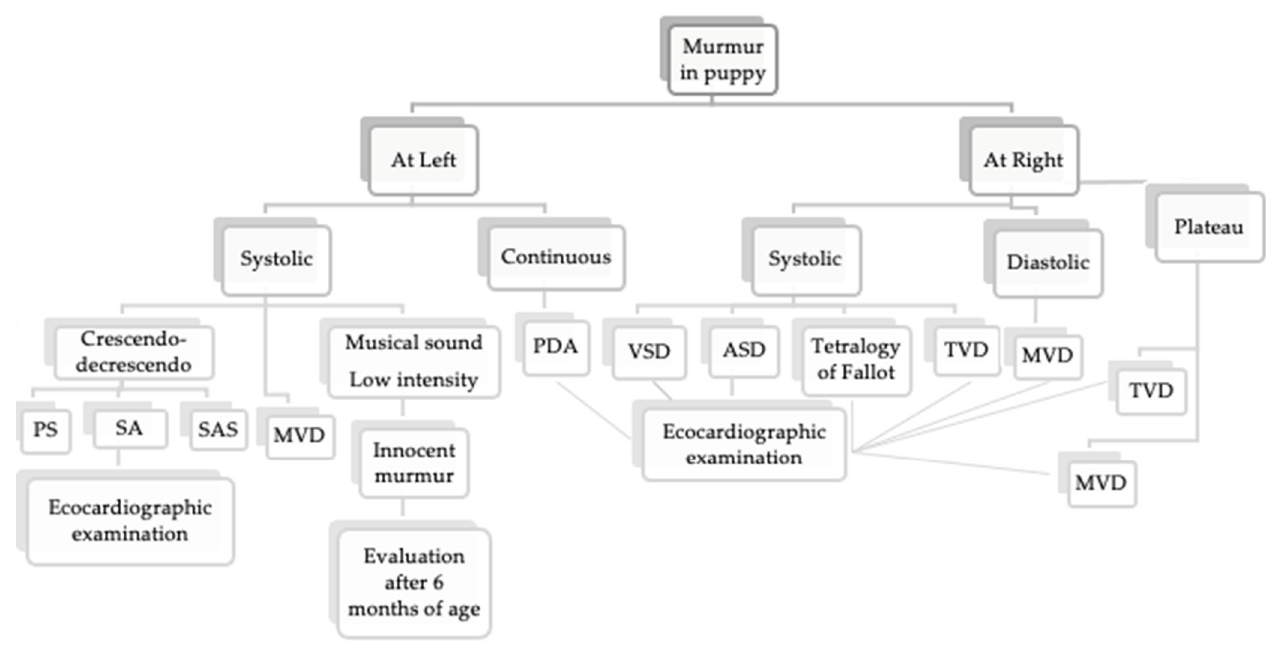
Figure 2. Protocol for assessment in presence of murmur in a >6-month-old puppy. PS, pulmonic stenosis; SA, stenosis aortic; SAS, stenosis subaortic; MVD, mitral valve dysplasia; TVD, tricuspid valve dysplasia.